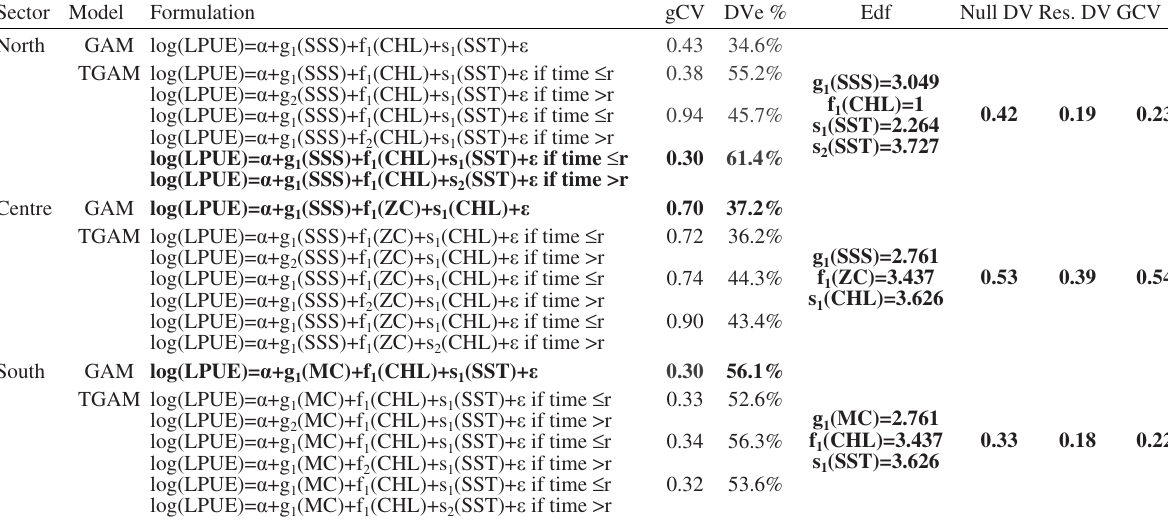
Fig. 6 . – Partial effects of sea surface temperature, sea surface salinity, chlorophyll a concentration, meridional current and zonal current for each sector during spawning periods. The median, 1st and 3rd quartiles and 95% distribution of the explanatory variables are shown along the x-axis as vertical grey lines. The shades areas indicate the 95% confidence interval. A,B,C,D, partial effects on LPUE in the Northern sector, where C and D are the partial effect of the sea surface temperature before and after June 2007, respectively; E,F,G, partial effects on LPUE in the Central sector; H,I,J, partial effects on LPUE in the Southern sector. See models in Table 2. Table 2. – Genuine cross-validation scores (gCV) used to select the models in each sector with the best prediction performance among candidate models and % of the deviance explicated (DVe %). The final models are indicated in bold text with the analysis of deviance of the covariates (SSS, sea surface salinity; SST, sea surface temperature; CHL, Chlorophyll concentration; ZC, zonal current velocity; MC, meridional current